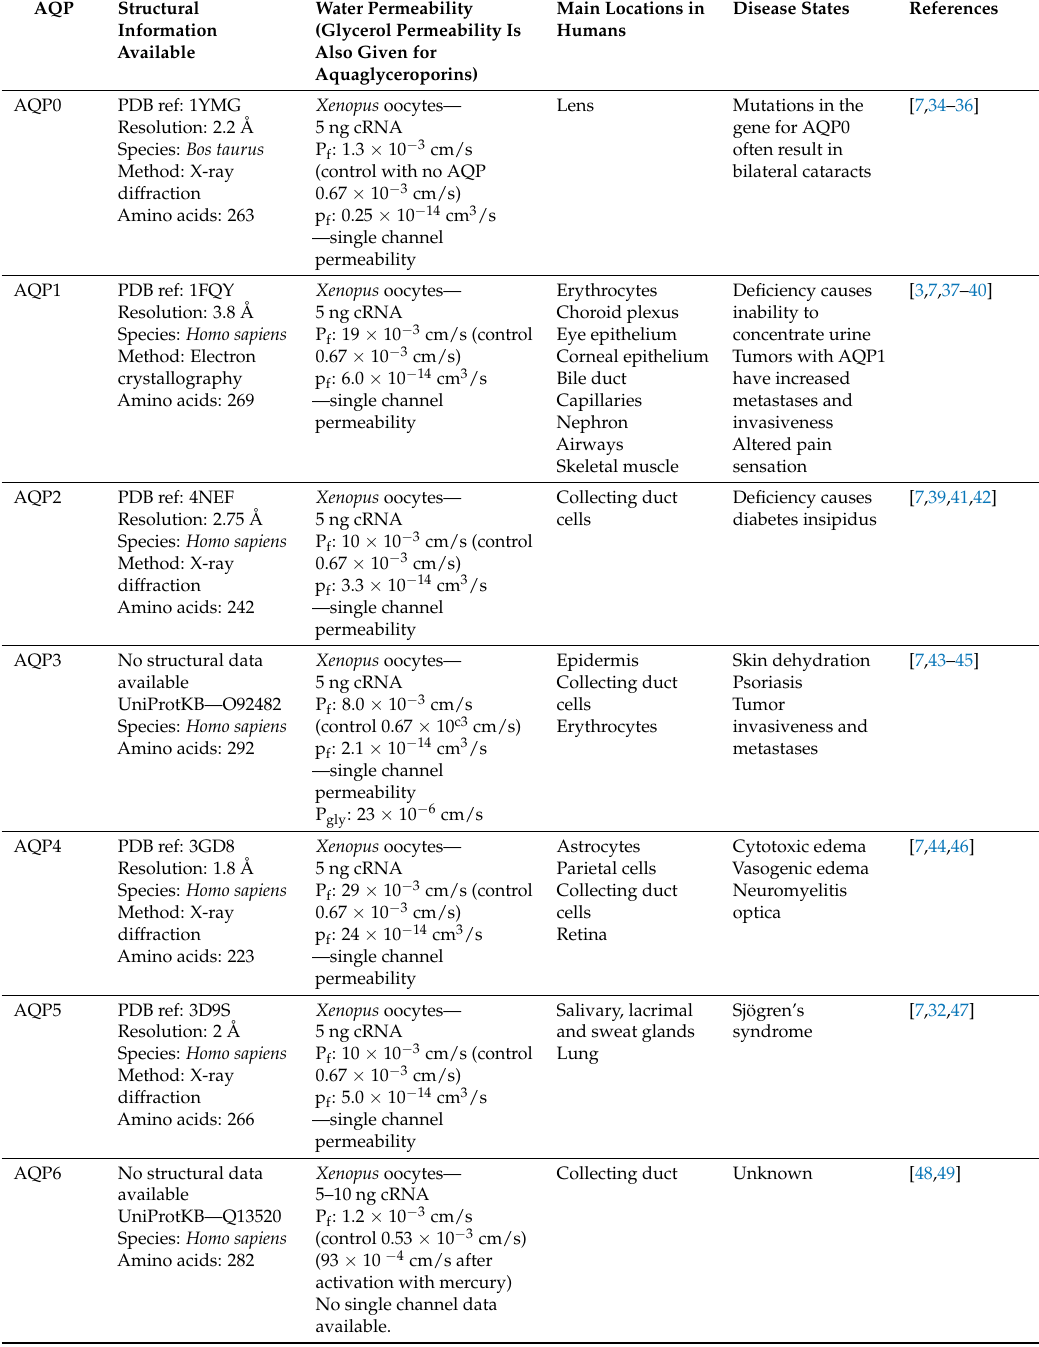
Table 1. A summary of AQPs 0–12 showing the information available on their structure, permeability, location within the body and pathophysiology. The osmotic water permeability coefficient (P f ) relates the magnitude of bulk water flow across a membrane in response to hydrostatic or osmotic pressure gradients to the magnitude of the driving pressure gradient. It depends on both the permeability of individual water channels and the density of channels in the membrane. P gly is the glycerol permeability coefficient. The single channel osmotic water permeability coefficient (p f ) is also given where